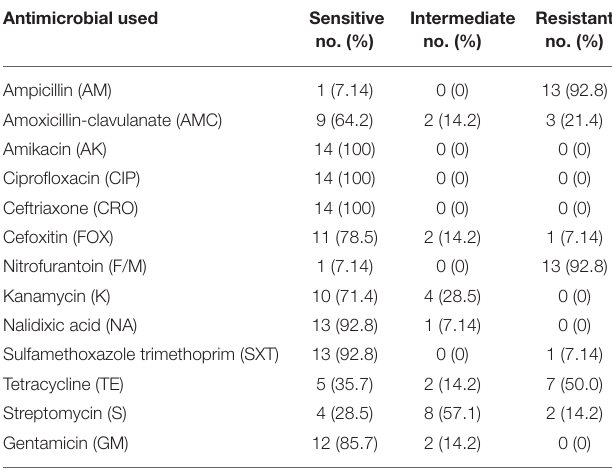
TABLE 3 | Antimicrobial susceptibility pattern of E. coli O157:H7 isolates ( n = 14). Antimicrobial used Sensitive no. (%)